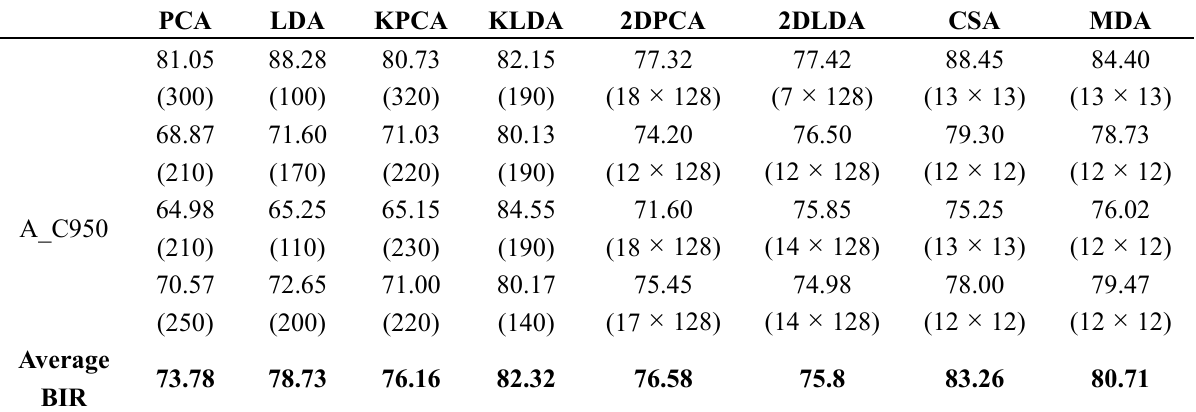
Table 5. BIRs and EERs of BLPOC and three orientation coding based methods conducted three times on three across-sub-databases (The value of J highest BIR or lowest EER is listed in